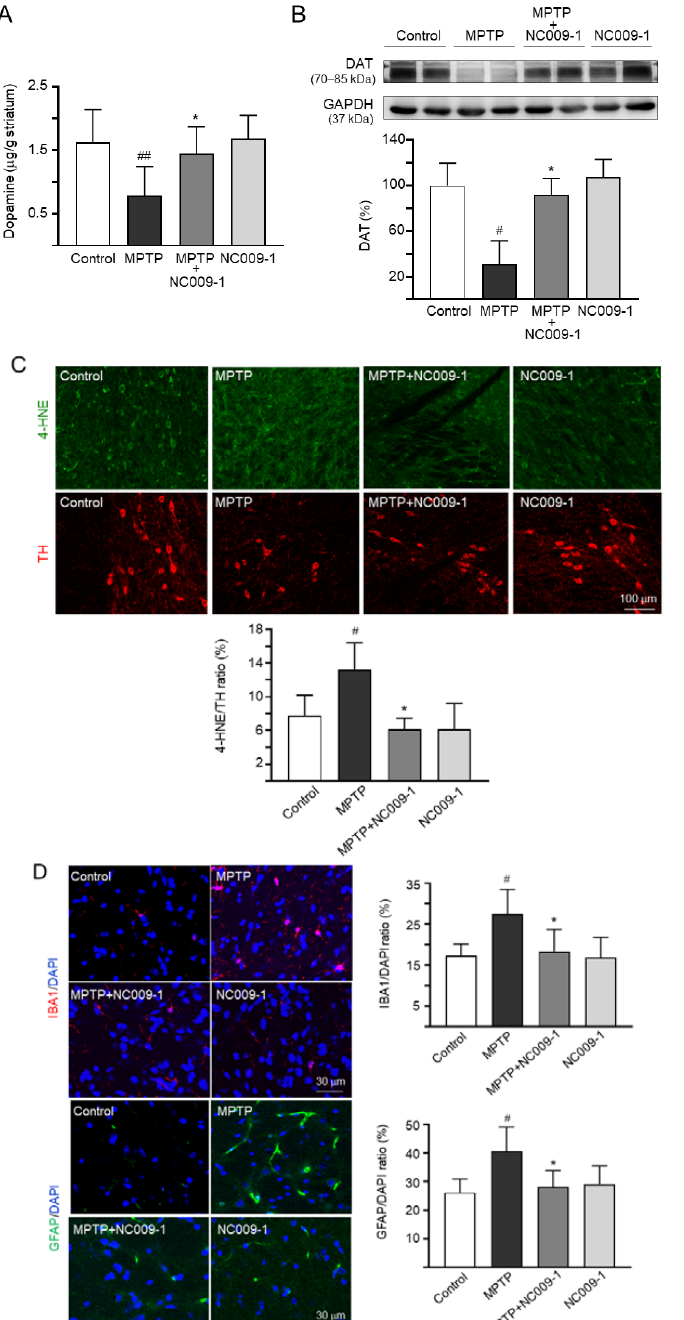
Figure 4. NC009 ‐ 1 attenuated the loss of striatal dopamine, oxidative damage, and neuroinflamma ‐ tion in MPTP ‐ PD mice. ( A ) HPLC quantitation of striatal dopamine ( n = 7). ( B ) Immunoblotting of striatal dopamine transporter (DAT) ( n = 6). ( C ) IHC stains of TH (red) and 4 ‐ HNE (green) ( n = 5). Quantitation of TH + neurons with oxidative damage, based on TH and 4 ‐ HNE co ‐ localization, is shown below. ( D ) IHC stains of IBA1 (red) and GFAP (green) at ventral midbrain ( n = 5). Nuclei were counter ‐ stained with DAPI (blue). Shown left of the images are quantitation of IBA1 and GFAP labeling. p values: comparisons between MPTP and control ( # p < 0.05, ## p < 0.01), or NC009 ‐ 1 ‐ treated and untreated MPTP mice (* p < 0.05).